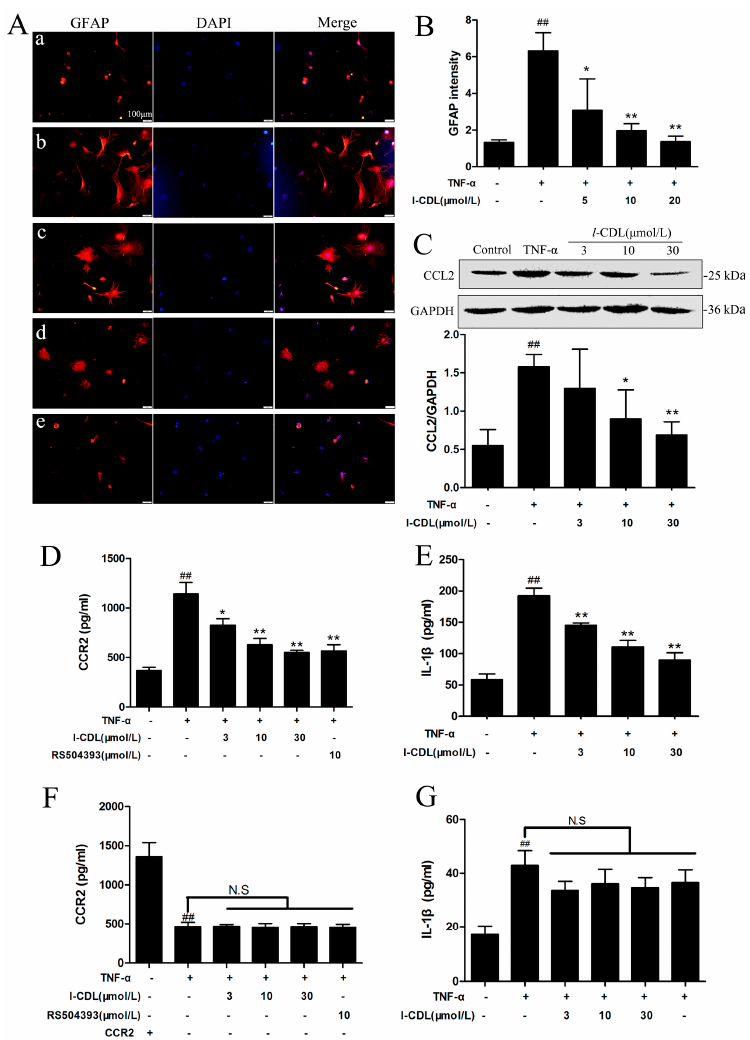
Figure 6. The effect of l -CDL on CCL2/CCR2 signal pathway in the astrocytes after pre-treatment with TNF- α . Astrocytes were pre-treated with TNF- α (10 µ M) for 2 h, then incubated with l -CDL (3 µ M, 10 µ M, 30 µ M) for 2 h. ( A ) Astrocytes were stained with GFAP antibody. Expression of GFAP expression (red) in activated astrocytes as visualized by fluorescence microscope. The blue staining represents DAPI. ( a ) control; ( b ) TNF- α (10 ng/mL); ( c ) TNF- α (10 ng/mL) + l -CDL (3 µ M); ( d ) TNF- α (10 ng/mL) + l -CDL (10 µ M); ( e ) TNF- α (10 ng/mL) + l -CDL (30 µ M). Scale bar = 100 µ m; ( B ) Graph showing the mean fluorescence intensity for GFAP; ( C ) Levels of CCL2 detected by western blotting; quantified and normalized to GAPDH levels. Each value was then expressed relative to the control, which was set 1; ( D ) The level of CCR2 protein in astrocytes ( E ) The level of IL-1 β in cell culture supernatant; ( F ) Effects of CCR2 siRNA on CCR2 expression level; ( G ) Effects of l -CDL on IL-1 β level in cell culture supernatant under the condition of CCR2 gene silencing. ## p < 0.01 vs. the control group; * p < 0.05, ** p < 0.01 vs. the TNF- α group, N.S, no significance (mean ± S.D., n = 3).